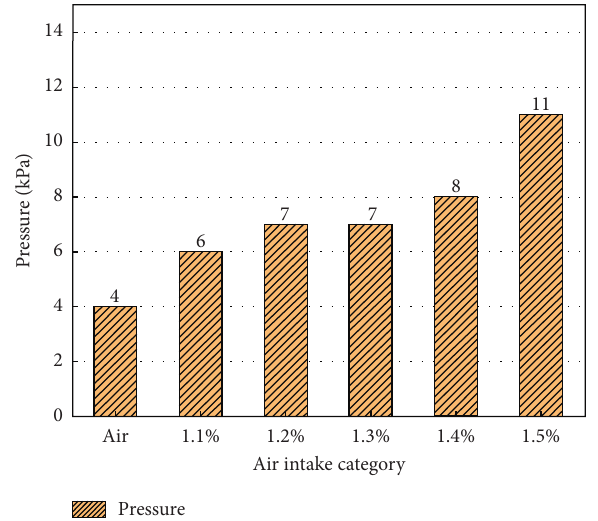
Figure 11: Pressure difference between inlet and